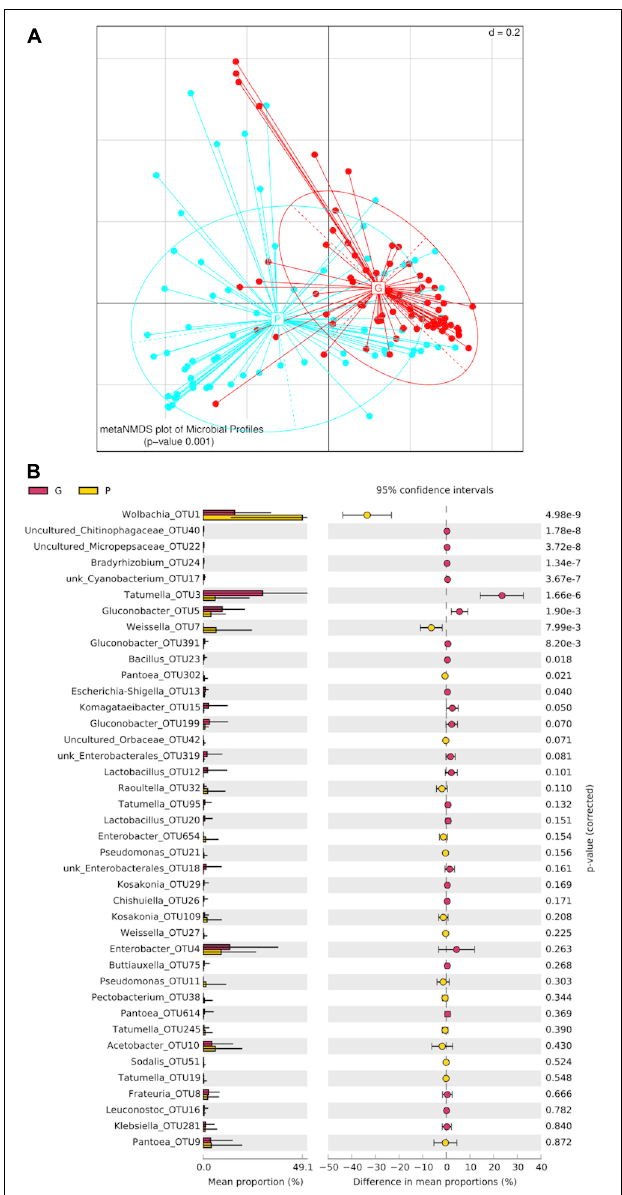
FIGURE 4 | Host fruit effect on the larval gut bacteriome of wild Anastrepha fraterculus . (A) Meta Non-metric Multidimensional scaling (meta NMDS) plot representing sample groups according to the host fruit where larvae originated: guava (G) or peach (P). Significance p -value from PERMANOVA analysis; d = 0.2. (B) Host fruit effect on OTUs relative abundance mean: the plot presents the mean proportion of reads for each OTU to the left (bars show mean value and standard error) the difference in mean proportions for each pair of comparisons (as well as its associated p -value according to Welch’s T -test).